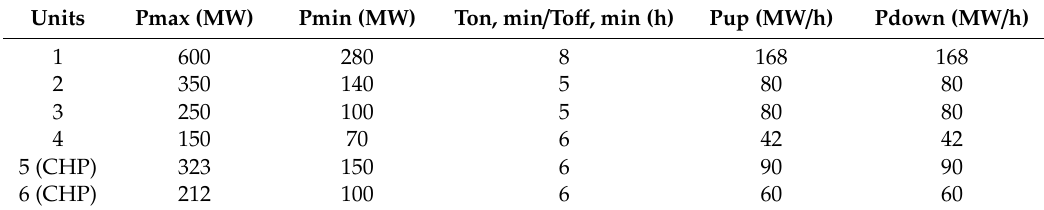
Table 2. The operation parameters of thermal power units.